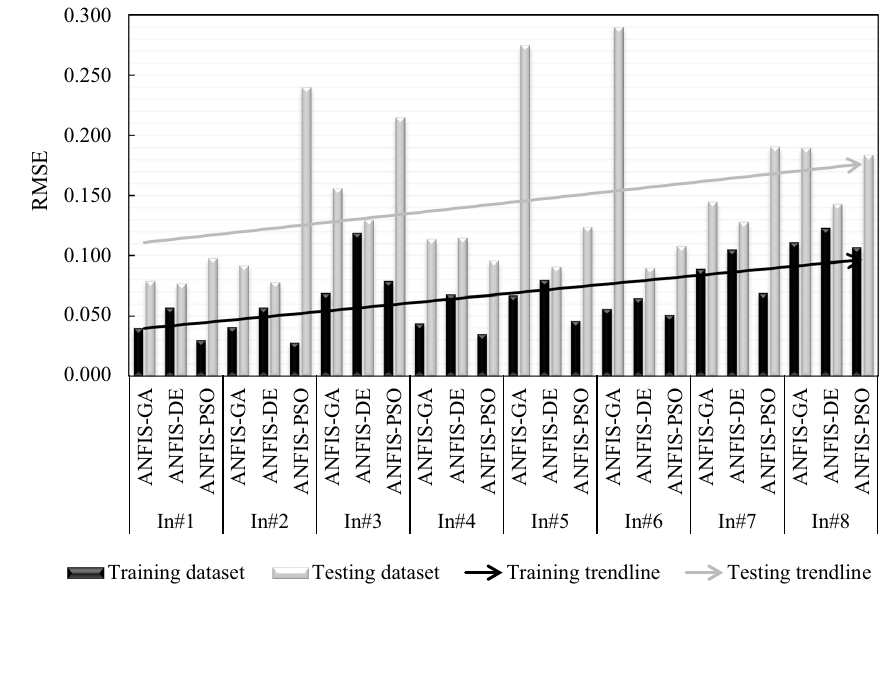
Fig. 11 Residual scatterplots of the considered hybrid ANFIS models